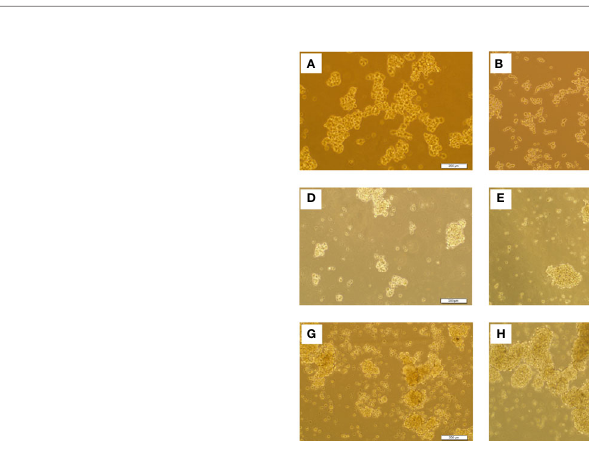
FIGURE 8 | Spheroid Derived Cells (SDCs) With Stem Cell-Related Features Before and After SMAD4 Transfection. Sphere formation assay in serum-free de fi ned medium (SFDM) compared to the self-renewal capacity 3D sphere derivatives of the PCs after SiSMAD4 inhibition during 6 days ( A :1st to G :7th day). (H) SDCs before transfection with SiSMAD4 showed signi fi cantly higher sphere-forming ability after 10 days. Figures are shown with a magni fi cation of